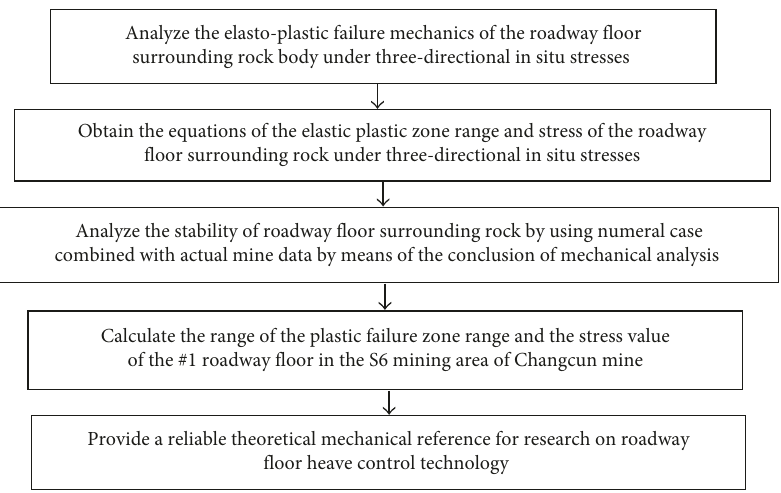
Figure 1: The flowchart for the